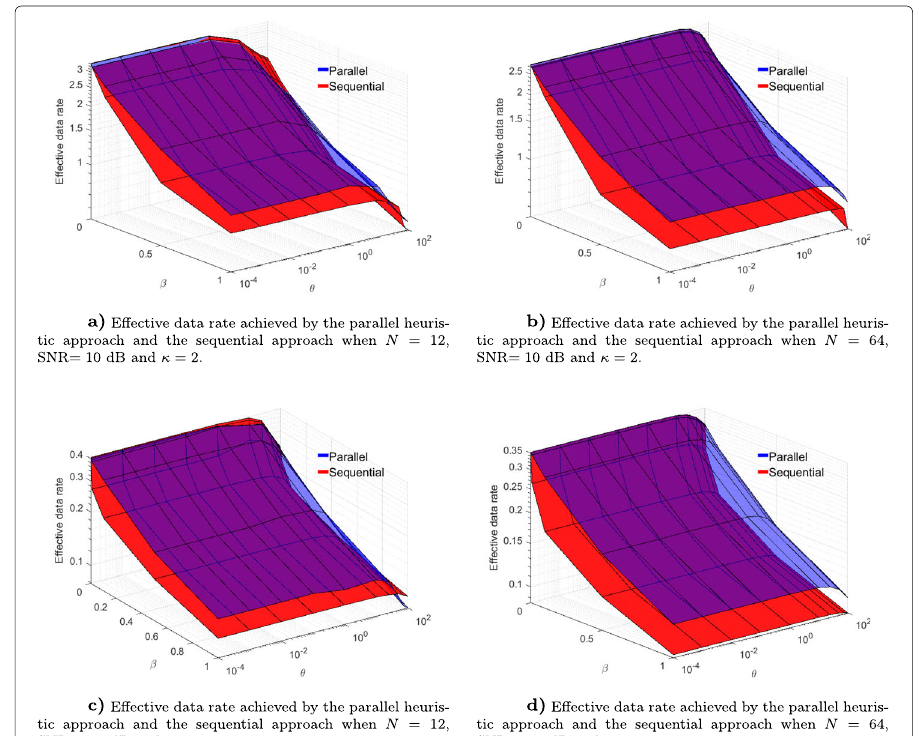
Fig. 7 a Effective data rate achieved by the parallel heuristic approach and the sequential approach when N = 12, SNR = 10 dB, and κ = 2. b Effective data rate achieved by the parallel heuristic approach and the sequential approach when N = 64, SNR = 10 dB, and κ = 2. c Effective data rate achieved by the parallel heuristic approach and the sequential approach when N = 12, SNR = 0.2 dB, and κ = 2. d Effective data rate achieved by the parallel heuristic approach and the sequential approach when N = 64, SNR = 0.2 dB, and κ =